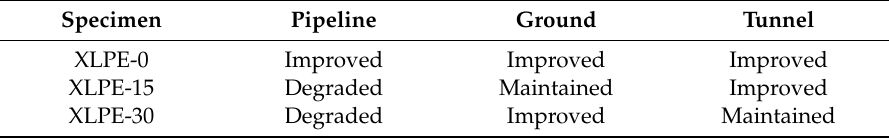
Table 3. Status of the degradation and stability of the specimens after thermal e ff